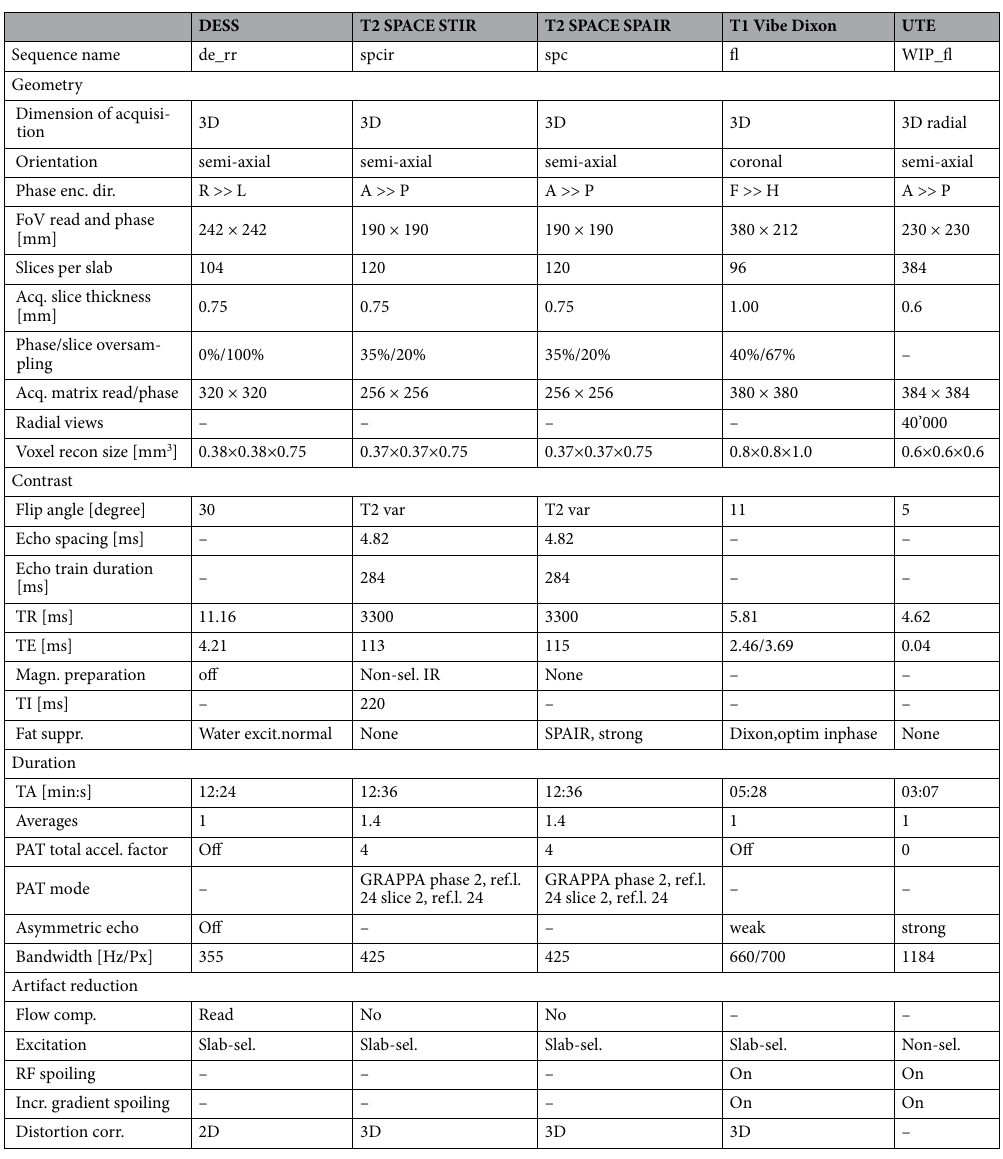
Table 1. The acquired sequences were 3D double-echo steady-state (DESS), 3D fast spin echo short-tau inversion recovery (SPACE-STIR), 3D fast spin echo spectral attenuated inversion recovery (SPACE- SPAIR), 3D volumetric interpolated breath-hold examination (T1-VIBE-Dixon), and 3D ultrashort echo time (UTE). Two fat saturation methods (STIR and SPAIR) for the SPACE sequence were compared, but all other parameters were kept equal. All sequences were acquired with sub-millimetric isotropic resolution and optimized for quality in a pilot study. Detailed sequence parameters are